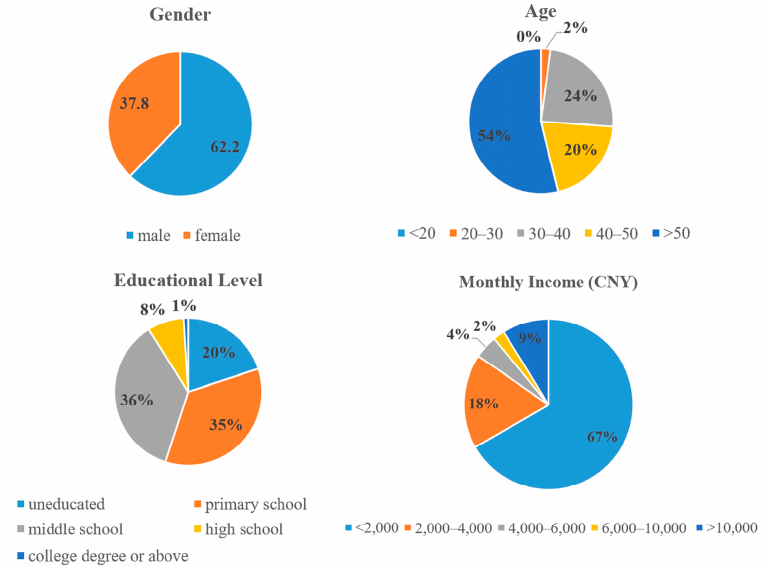
Figure 11. The descriptive statistics of samples from Doushan Village. Table 3. Residents’ satisfaction scores with multi-dimensional environments in Tianquan Commu- nity.